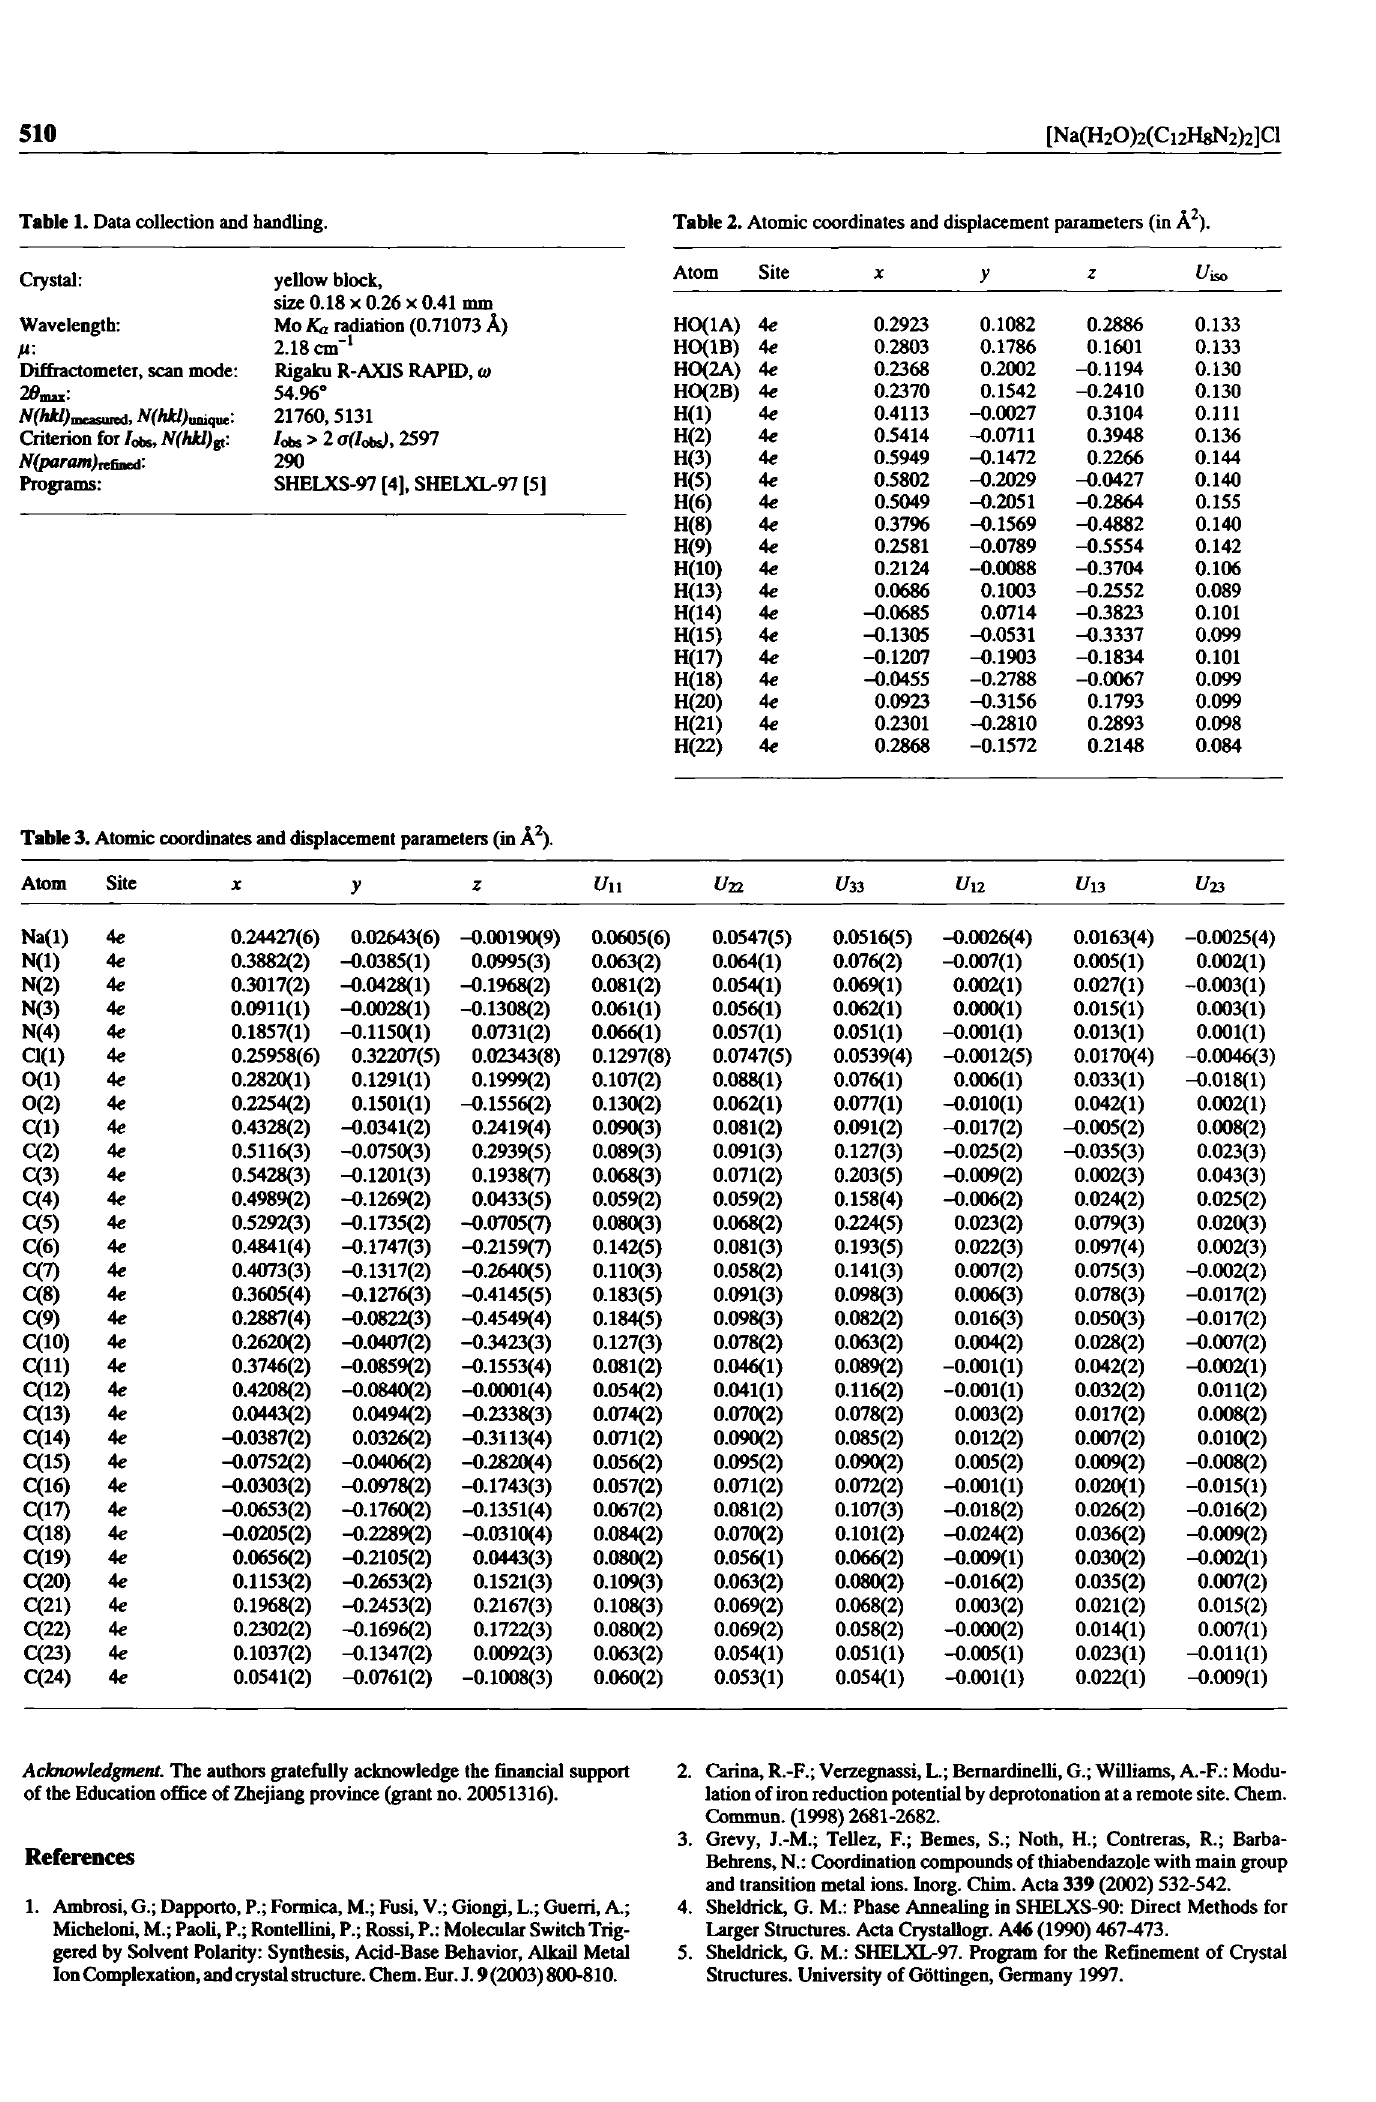
Table 3. Atomic coordinates and displacement parameters (in Ä 2